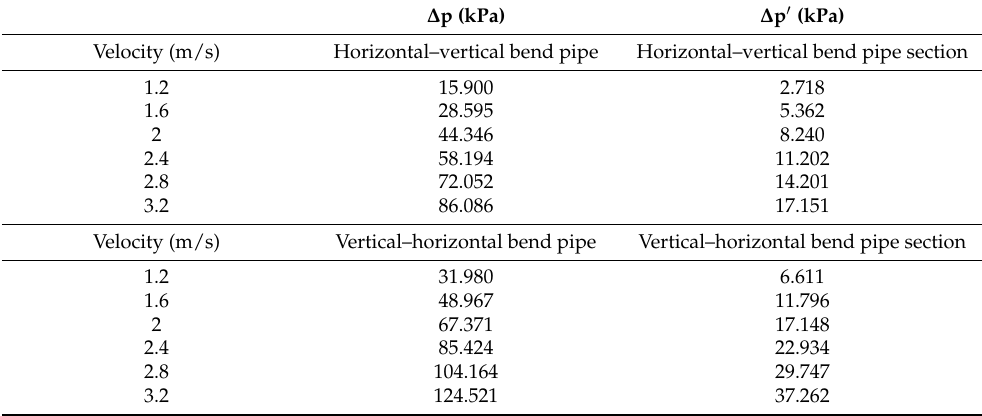
Table 2. Pressure loss in different pipe shape.